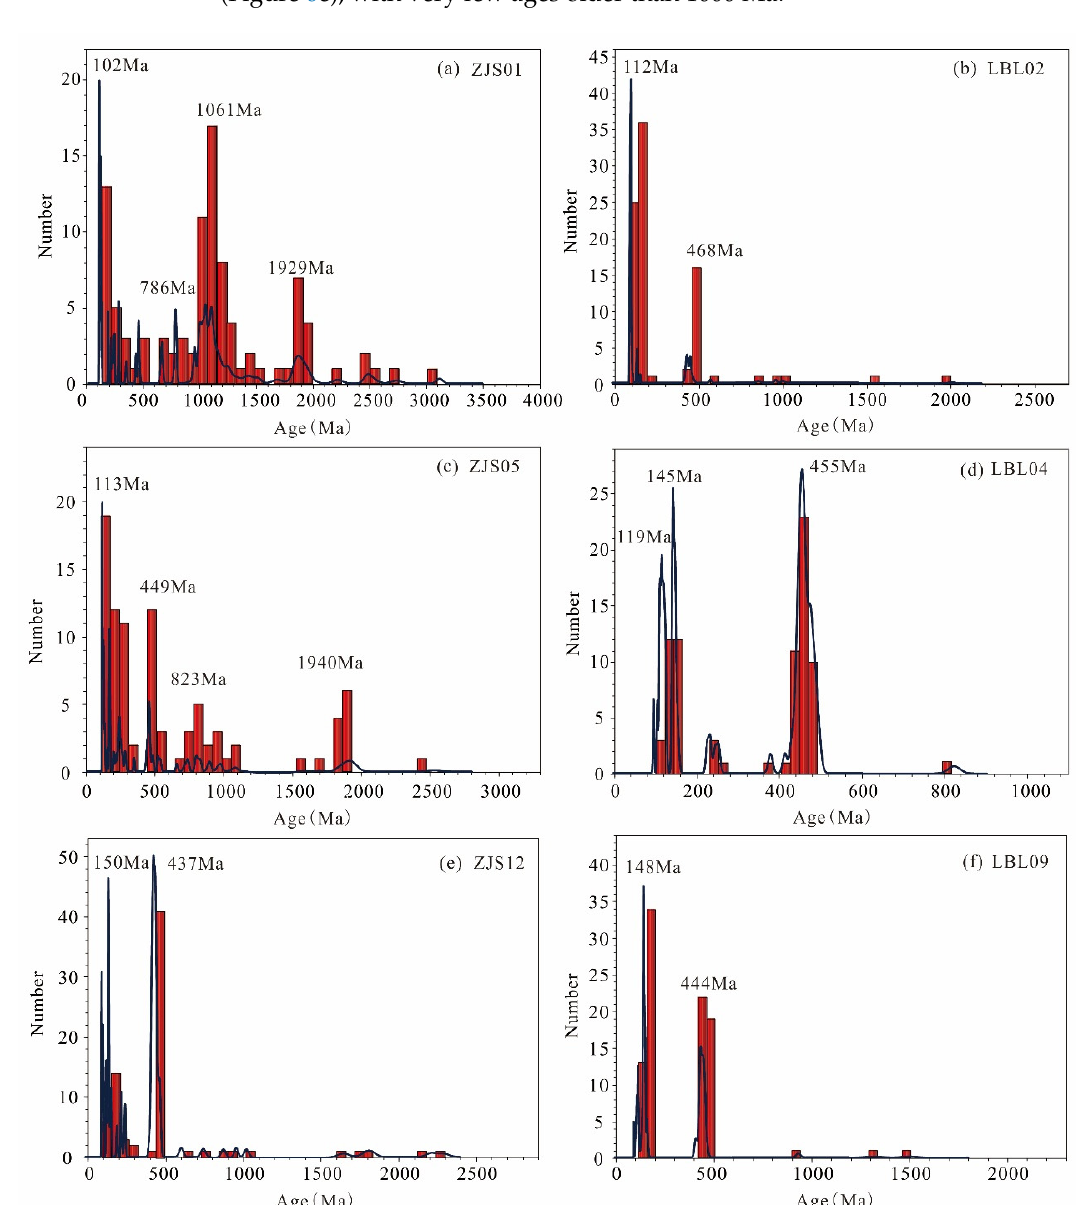
Figure 6. Probability curves of U–Pb ages for detrital zircons of stream sediments in the Zijinshan Copper-Gold Orefield. ( a ) Stream sediment numbered ZJS01 around Zijinshan Cu-Au deposit; ( b ) Stream sediment numbered LBL02 around Luoboling Cu-Mo deposit; ( c ) Stream sediment numbered ZJS05 around Zijinshan Cu-Au deposit; ( d ) Stream sediment numbered LBL04 around Luoboling Cu-Mo deposit; ( e ) Stream sediment numbered ZJS12 around Zijinshan Cu-Au deposit; ( f ) Stream sediment numbered LBL09 around Luoboling Cu-Mo deposit.